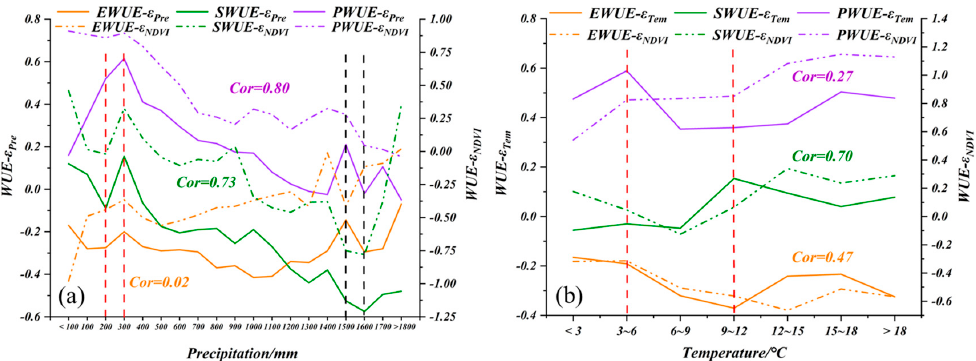
Figure 4. Sensitivity coefficients of WUEs to climatic factors: ( a ) precipitation and NDVI in Central Asia from 2000 to 2018; ( b ) temperature and NDVI in Central Asia from 2000 to 2018. The sensitivity of EWUE to temperature, precipitation and NDVI varied significantly across different seasons. Specifically, ε Pre changed from large to small in spring, winter, summer, and autumn; ε Tem from large to small in autumn, spring, summer, and winter; and ε NDVI from large to small in autumn, spring, winter, and summer. The contribution rates of temperature, precipitation, and NDVI to EWUE were consistent with the seasons.